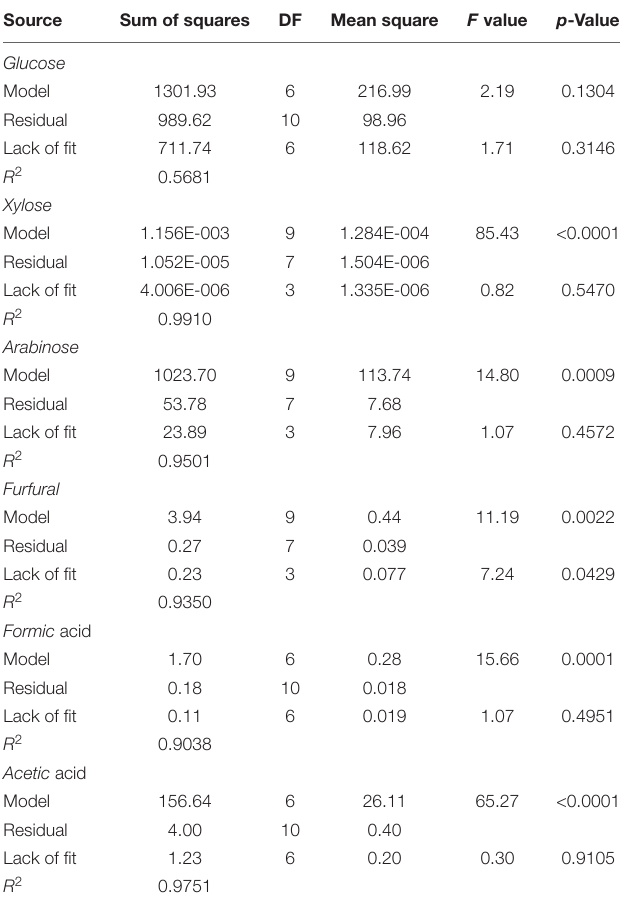
TABLE 3 | ANOVA Table of the adjusted models from dilute sulfuric acid pretreated and enzyme hydrolyzed corn fiber. Source Sum of